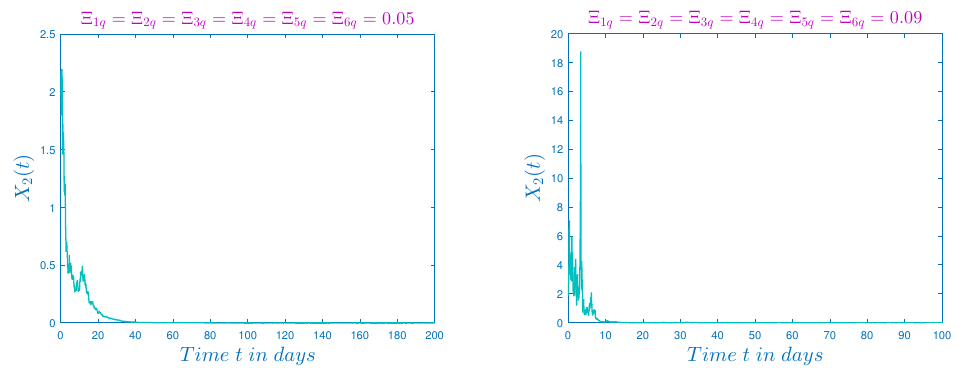
Figure 3. Numerical plot of the stochastic solution X k , k = 1,2,3,4,5,6 with different quadratic noise. The estimated deterministic values are selected from Table 2 and the linear stochastic amplitudes are chosen as follows: Ξ 1 (cid:96) = 0.07, Ξ 2 (cid:96) = 0.17, Ξ 3 (cid:96) = 0.1835, Ξ 4 (cid:96) = 0.764, Ξ 5 (cid:96) = 0.148, Ξ 6 (cid:96) = 0.141.